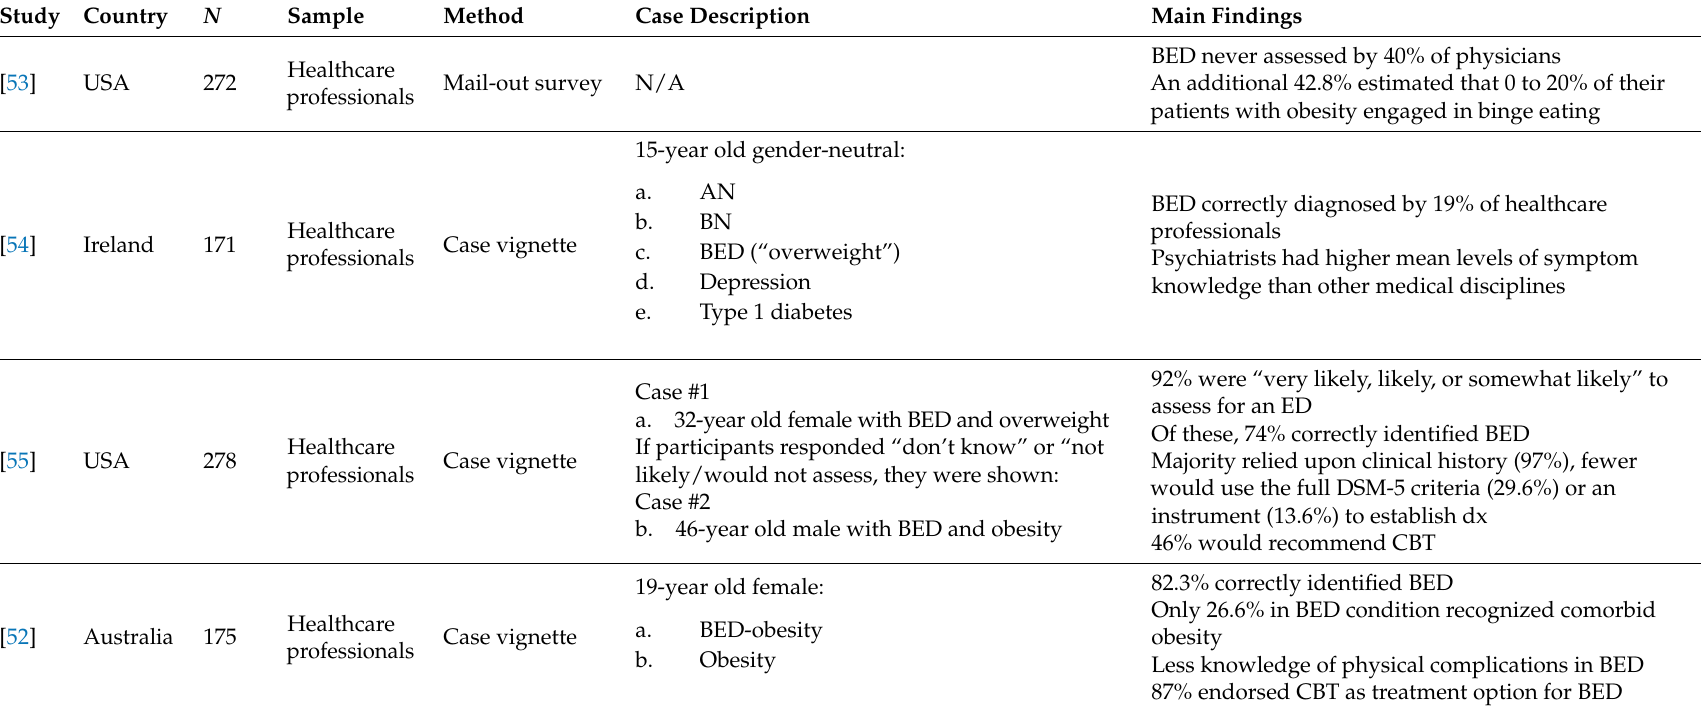
Table 2. Study characteristics of investigations of healthcare professionals’ attitudes and knowledge of